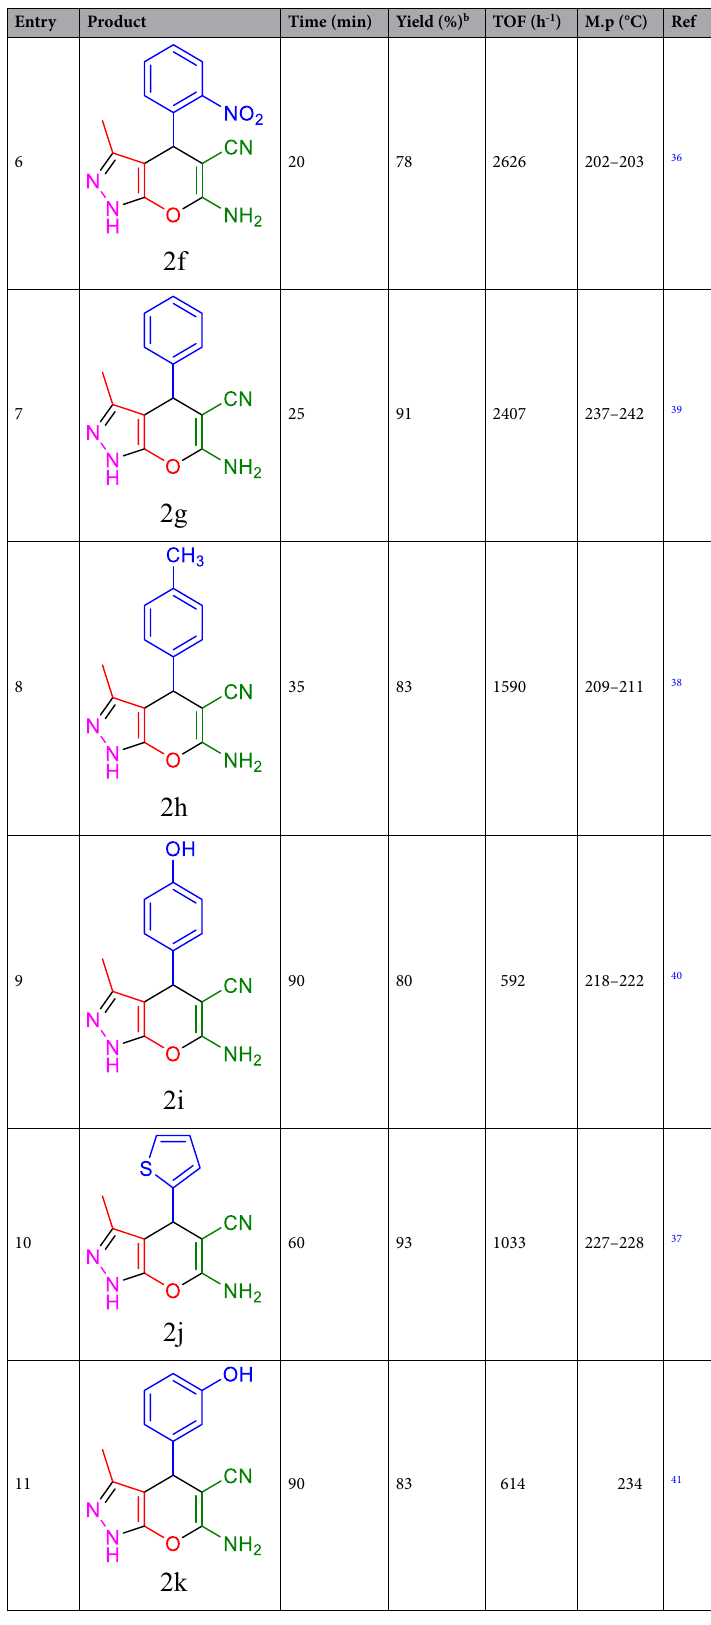
Table 6. One-pot synthesis of 1,4-dihydropyrano[2,3-c]pyrazole with aldehyde, malononitrile, ethyl acetoacetate and hydrazine hydrate catalyzed by HMS/Pr-Xa-Ni a . a Aldehyde (1 mmol), malononitrile